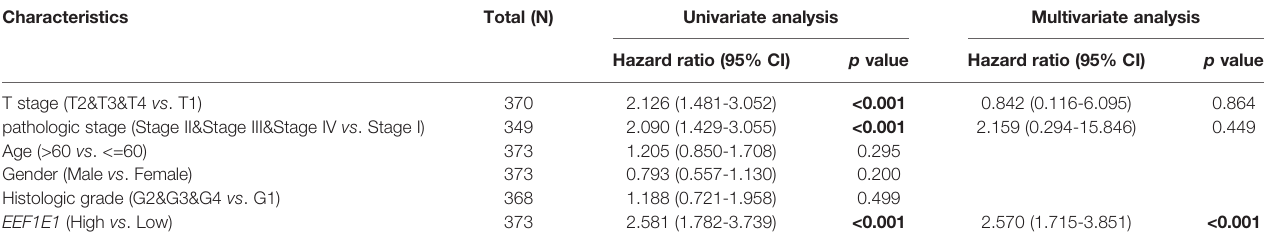
TABLE 3 | Univariate analysis and multivariate analysis of liver cancer patient ’ s overall survival.